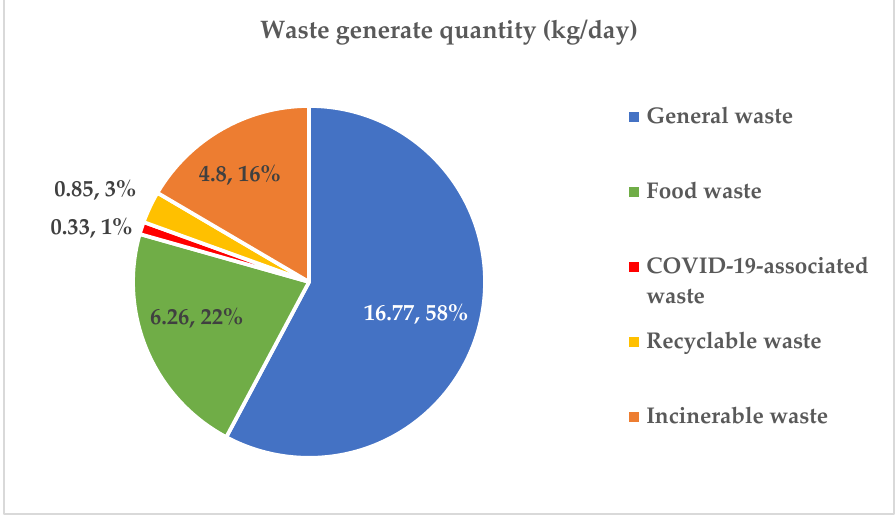
Figure 1. Overview of the distribution of the five types of waste generated.